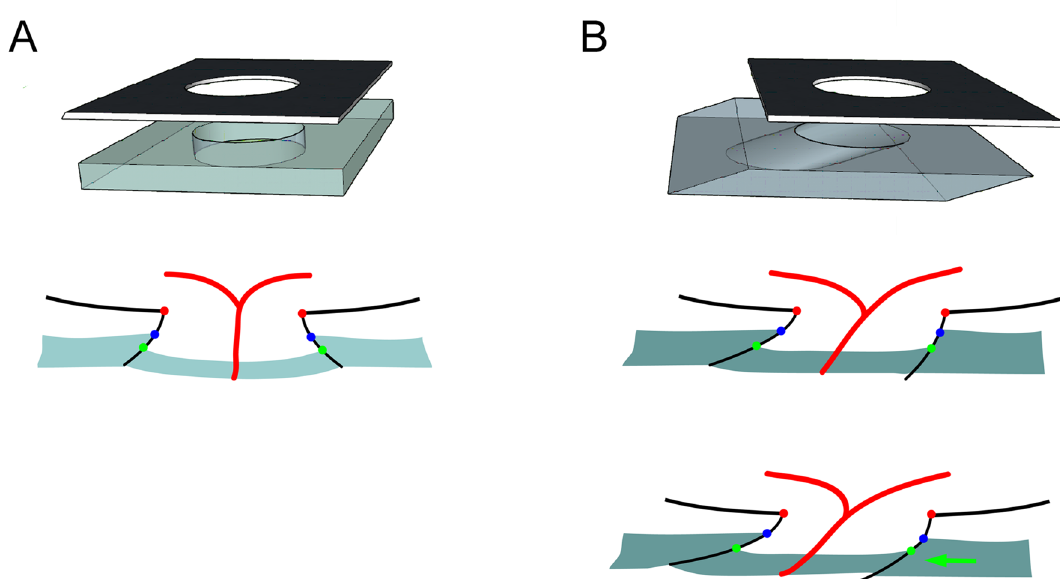
Figure 7. Schematic illustration of optic nerve head (ONH) canal in absence ( A ) and presence ( B ) of outer- wall shift. The intervening choroid is omitted for clarity. (Top) Three-dimensional view. A black overlying plane indicates the Bruch’s membrane opening (BMO), and the underneath cuboid with central hole indicates the scleral part of the ONH canal with the anterior scleral opening (ASCO) on the surface. (Bottom) Cross-sectional view. The red dots indicate the BMO margin, the blue dots the ASCO margin, the green dots the anterior lamina cribrosa (LC) insertion site, and the red lines the central retinal vascular trunk (CRVT). The peripapillary border tissue of the choroid (PBT-C) is the black line between the red and blue dots, and the peripapillary border tissue of the scleral flange (PBT-S) is the black line between the blue and green dots. The ASCO/BMO offset is the misalignment between the red and blue dots, and the LC/BMO offset, between the red and green dots. As the LC is located in a lower part of the ONH canal than the ASCO is, the LC/BMO offset is generally larger than the ASCO/BMO offset if the PBT-C and the PBT-S share a common directionality ( B , Middle). If the PBT-S rotates further than the PBT-C, however, the LC/BMO offset can increase independently of the ASCO/ BMO offset ( B , Bottom; green arrow). We speculated that this could happen, due to the fact that the upper layer (the posterior polar retinal structure) is selectively affected by the restriction against expansion, whereas the lower layer (sclera and LC) is